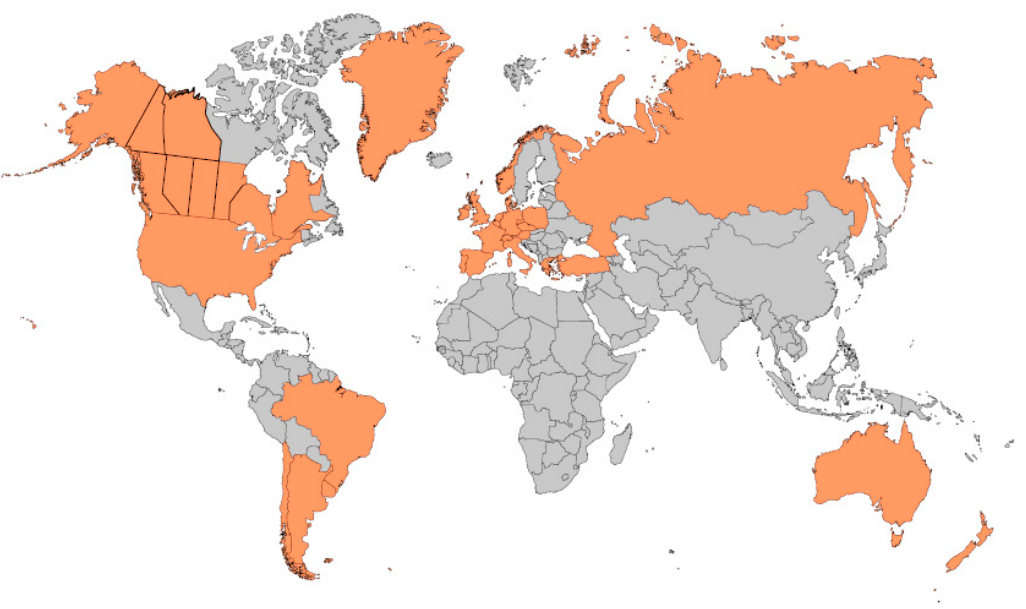
Figure 1. Worldwide implementation of cystic fibrosis newborn screening as of 2020.